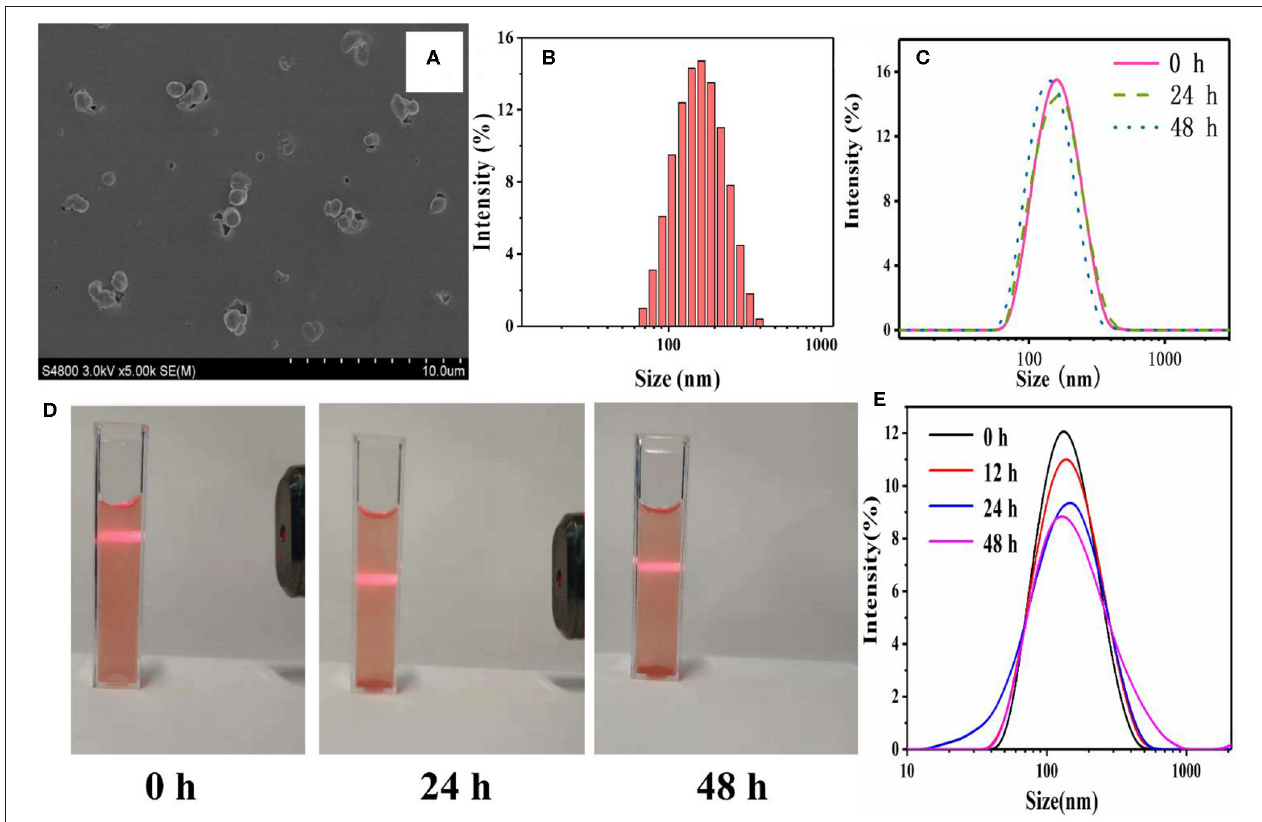
FIGURE 3 | Characterizations of HY/SS-CONs. (A) SEM image and (B) DLS pattern; (C) Storage stability of DOX-loaded HY/SS-CONs at pH 7.4; (D) Tyndall phenomena of DOX-loaded HY/SS-CONs at pH 7.4; (E) Hemodynamic stability of HY/SS-CONs in PBS pH 7.4 containing 5% BSA at 37 ◦ C.